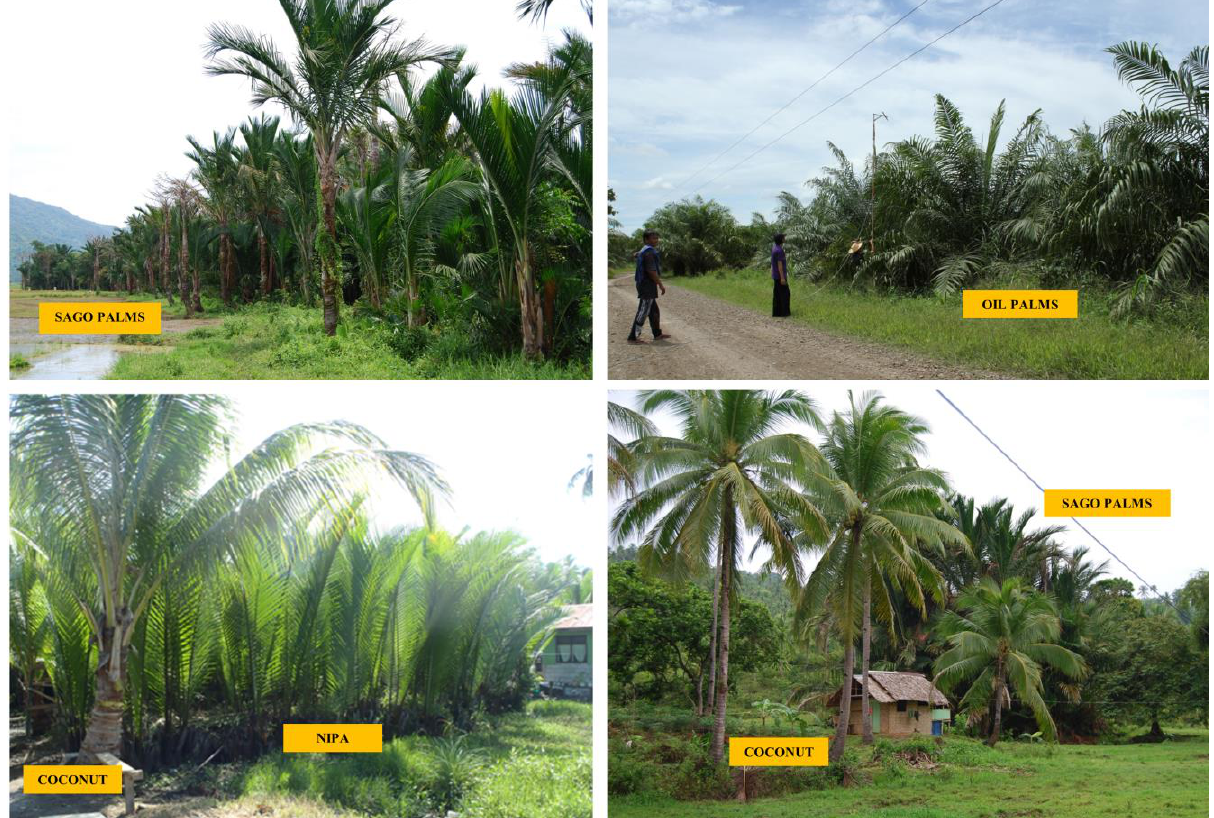
Figure 1. Pictures of sago palms, coconut, oil palm and